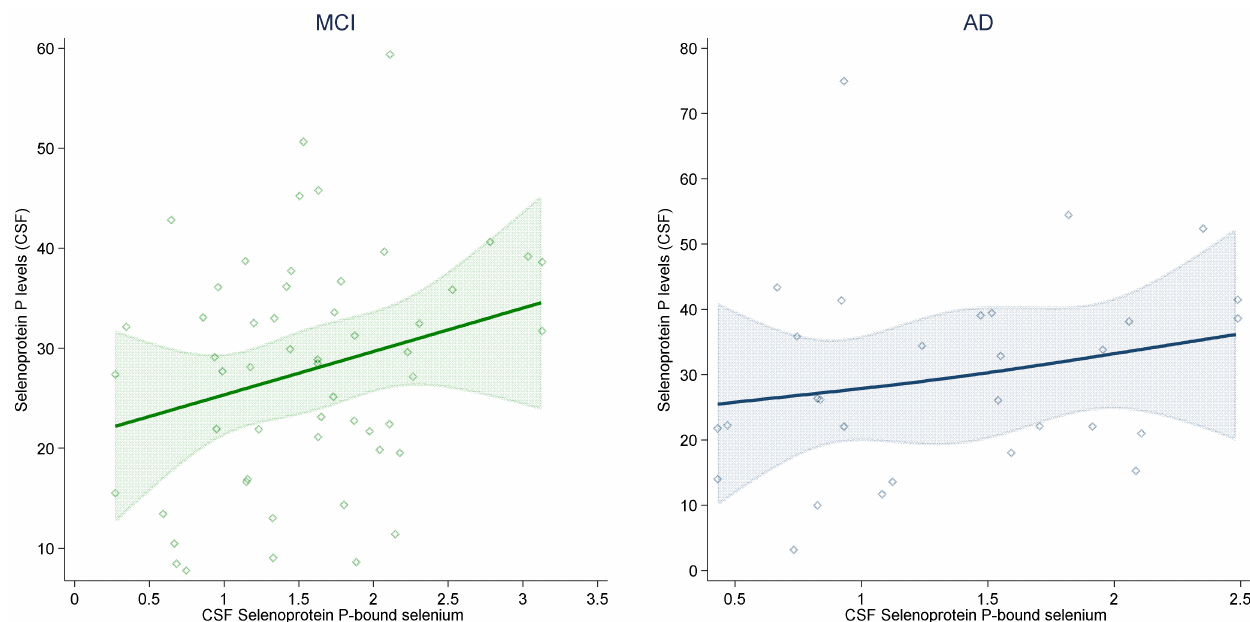
Figure 3. Association between selenoprotein P levels and selenoprotein-P-bound selenium in cere- brospinal fluid (CSF) (ng/mL) in individuals with mild cognitive impairment (MCI) and Alzheimer’s dementia (AD) in spline regression analysis adjusted for age, sex and education, with 95% confi- dence limits. Table 2. Odds ratio (OR) and 95% confidence interval (CI) of Alzheimer’s disease (AD), mild cognitive Table 1. Cerebrospinal fluid (CSF) and serum levels of selenoprotein P and CSF levels of impairment (MCI) and amyotrophic lateral sclerosis (ALS) versus controls for 10-unit continuous selenoprotein-P-bound selenium, amyloid-beta and phosphorylated and total tau in relation to increase in selenoprotein P levels. diagnosis.